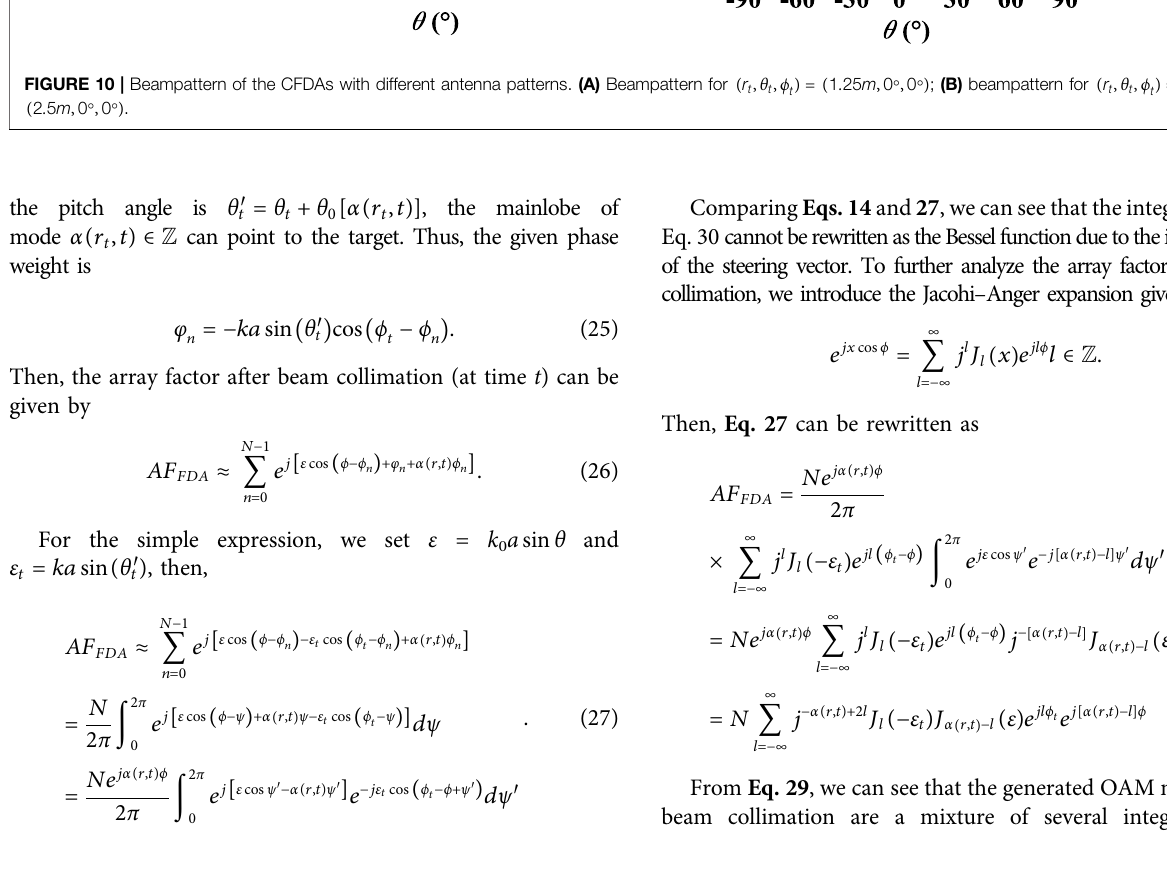
Frontiers in Physics |